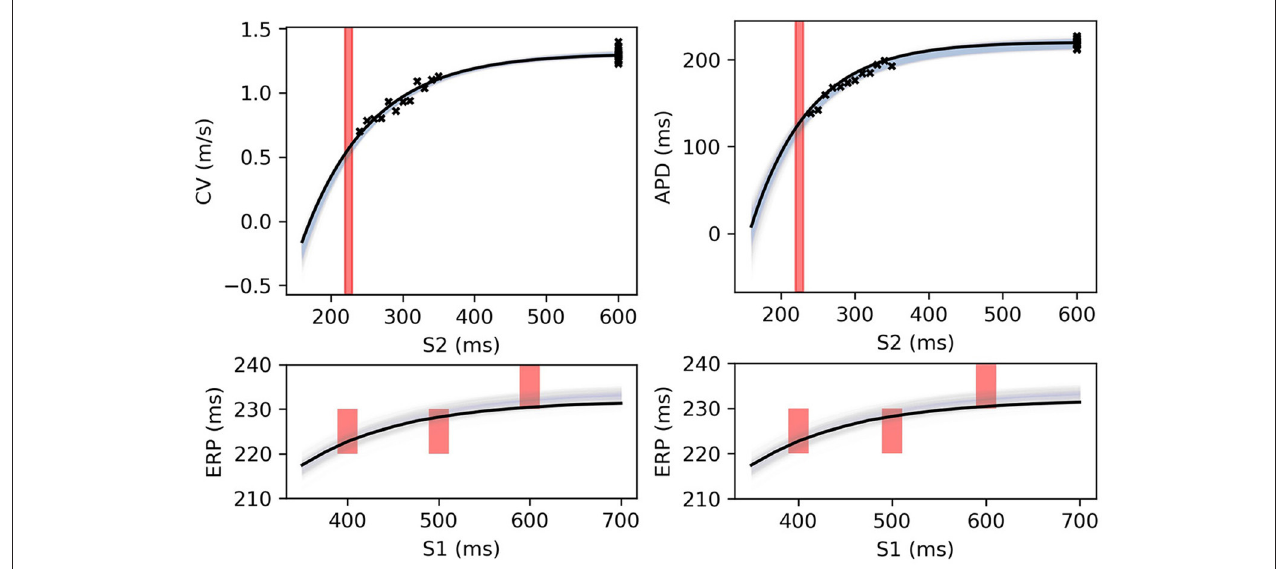
FIGURE 12 | RCE predictions, shown as lightly shaded regions representing 95% confidence intervals, for 100 parameter samples from the posterior distribution given the same measurements shown in Figure 8 (black crosses are noisy S2 restitution data, red bars are observed ERP intervals). MCMC utilized CV(S2), APD(S2), and ERP(S1) data simultaneously, unlike in Figures 8 , 9 .